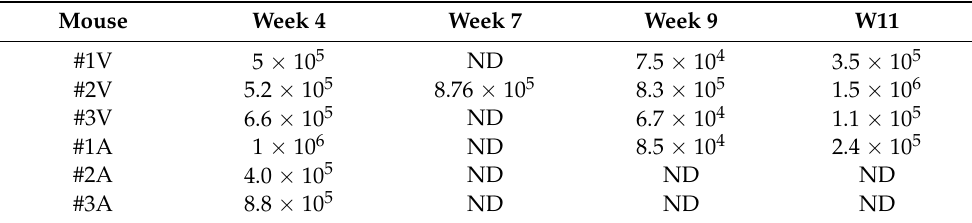
Table 4. Viral DNA copy numbers in vaginal (V) and anal (A) tracts of three mice infected with L1-L2ATGko mutant MmuPV1 over